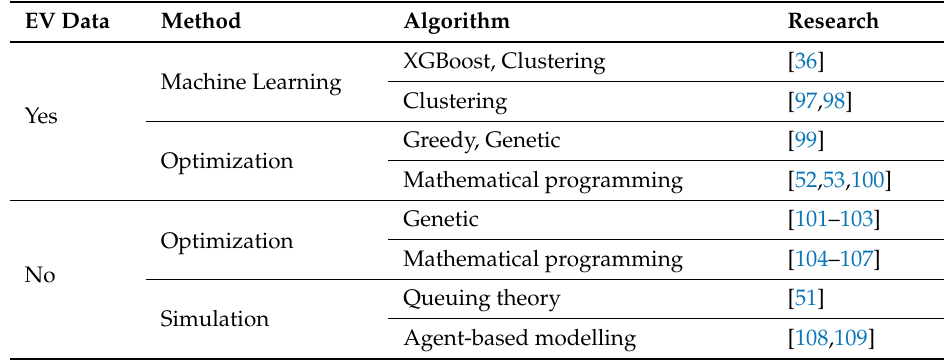
Table 4. Categorization of studies about charging station (CS) deployment based on data and